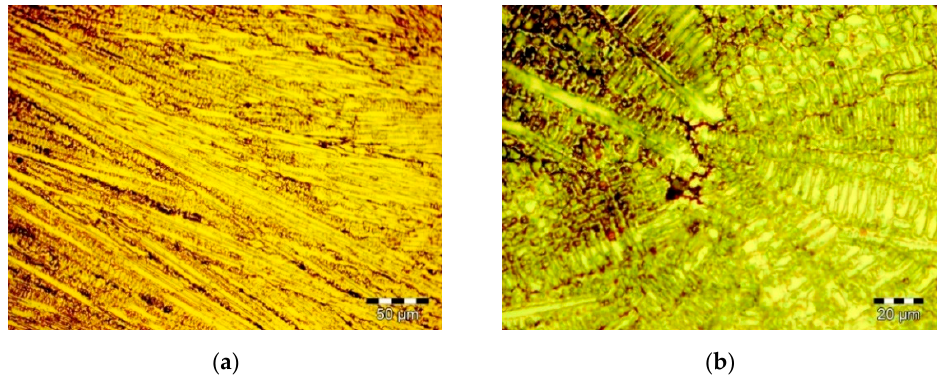
Figure 1. Microstructure of the CoCrMo alloy: ( a ) sample lateral area; ( b ) detail of the sample central area.